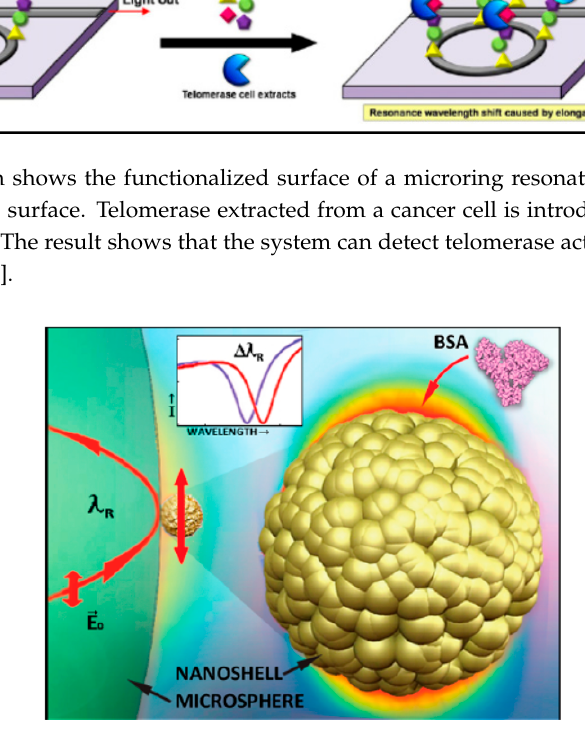
Figure 16. 3D model shows the mechanism of BSA binding with gold nanoshell particle at the equator of a dielectric microsphere with WGM. The WGM-h enhancement and adsorption of the biomolecule caused the resonant wavelength shift. Reprinted with permission from [141].